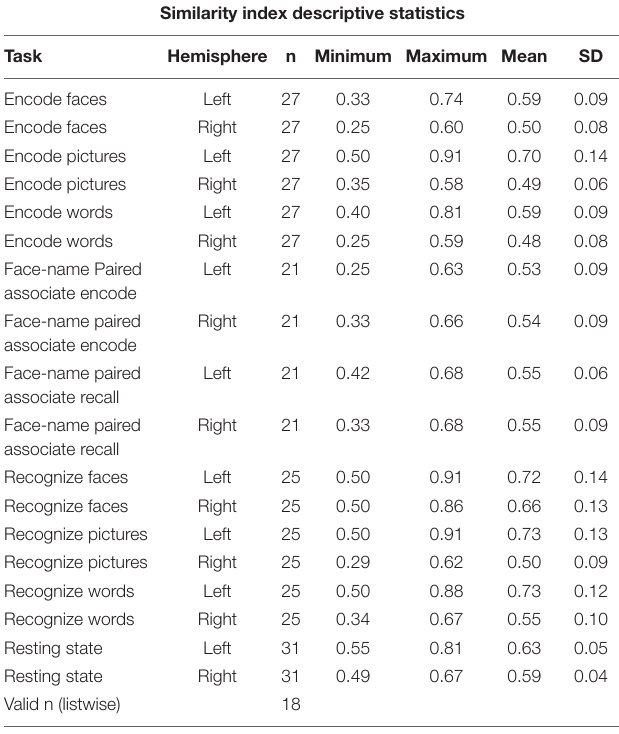
TABLE 1 | Similarity index descriptive statistics, by task, condition, and